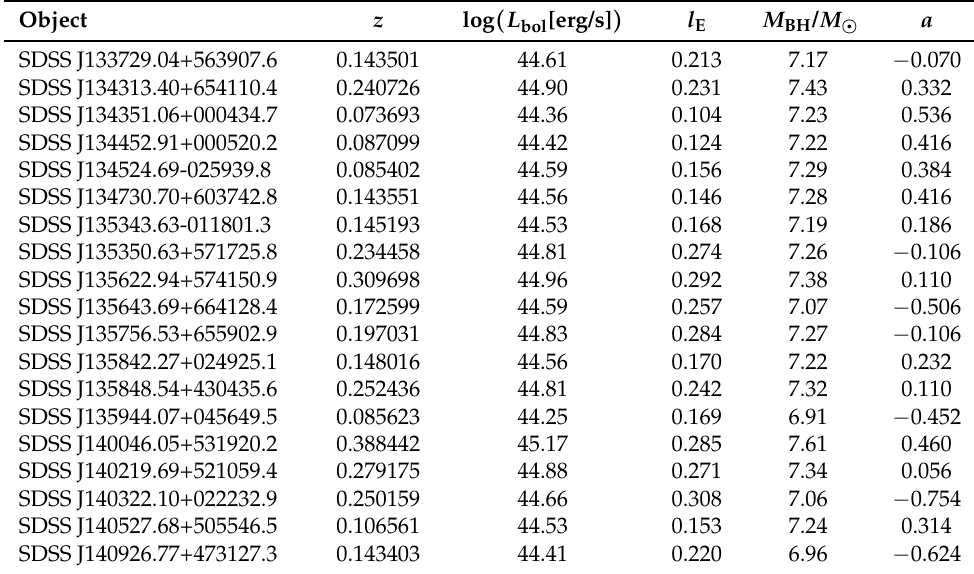
Table A6. All objects with their estimated spin values. Part 6 of